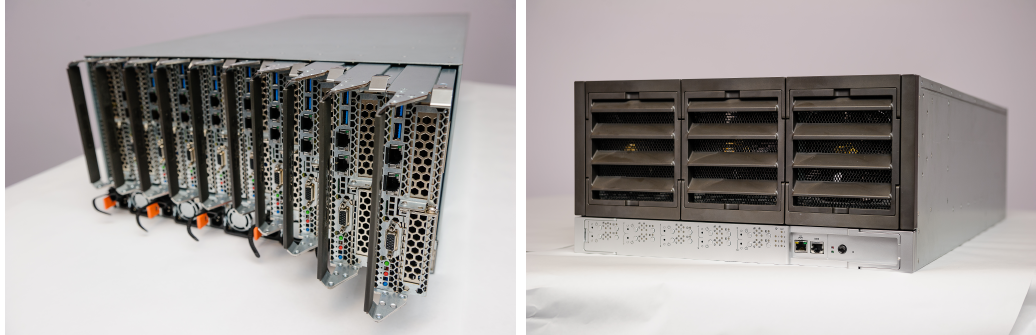
Figure 2: T-Platforms V-Class components used in the JURECA system. Copyright: T-Platforms.